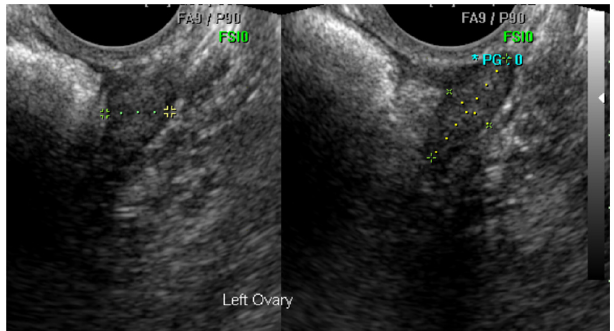
Figure 1. Transverse (TS) and longitudinal (LS) transvaginal ultrasound images of left ovary acquired by sonographer. This ovary was confirmed as normal and correctly measured by the expert